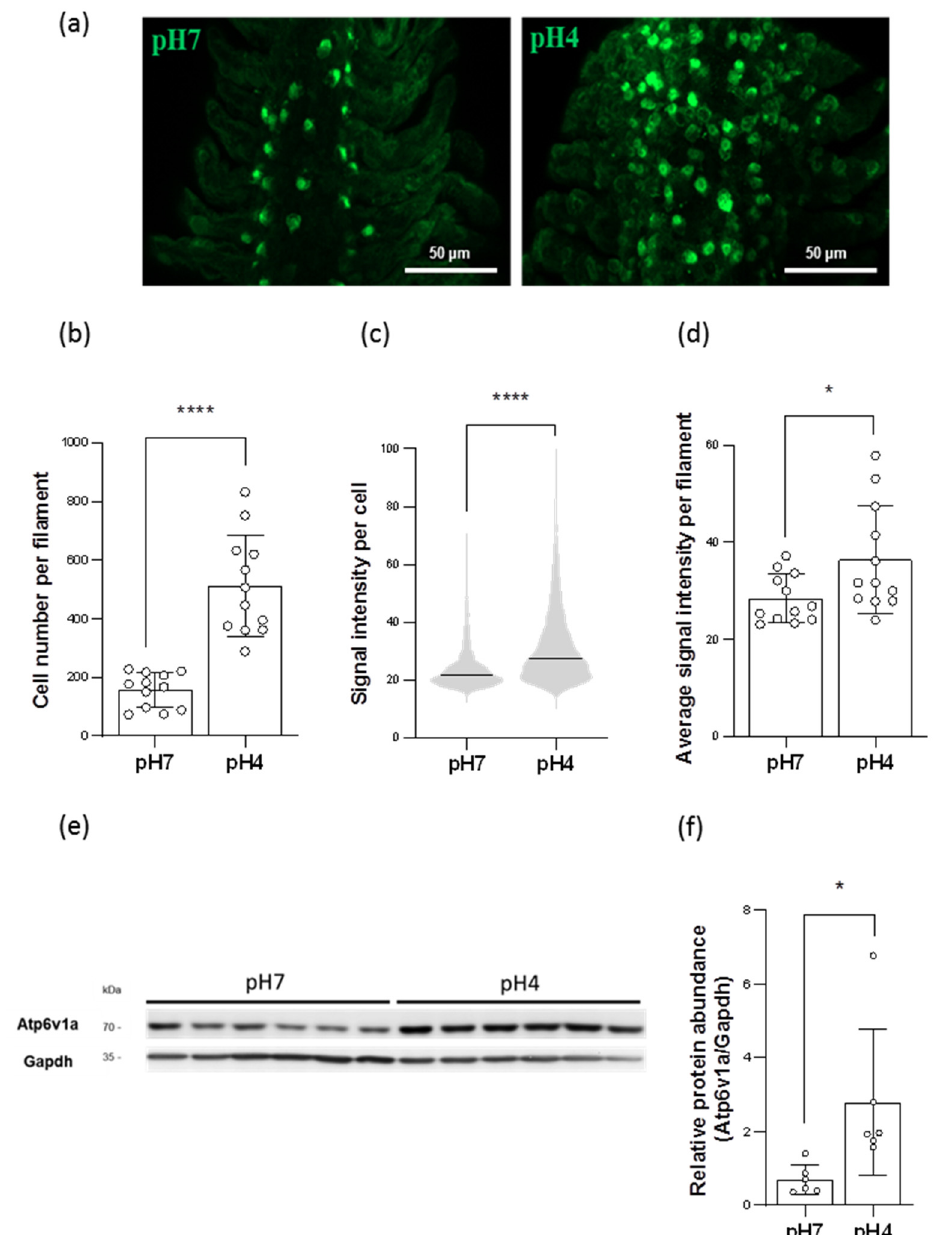
Figure 3. Effects of acid acclimation on the number of HR ionocytes and the expression of HA in the gills. The number of HR ionocytes and the fluorescence intensity of Atp6v1a signals in the gills were analyzed by immunofluorescence (IF) after acid acclimation ( a ). HR ionocyte number of filaments (N = 12) ( b ), mean fluorescence intensity of individual HR ionocytes (N = 1894–6144) ( c ), and average mean fluorescence intensity of HR ionocytes of filaments (N = 12) ( d ) were presented. The protein expression of HA in the gills acclimated to acid environments was analyzed by Western blot. The blots showed the bands with molecular weights corresponding to Atp6v1a and Gapdh (approximately 70 kDa and 35 kDa, respectively) ( e ). The protein expression of HA was quantified and normalized to Gapdh (N = 6) ( f ). Values are the mean ± SD or SEM. Student’s t -test or Mann–Whitney U test, * p < 0.05, **** p < 0.0001.